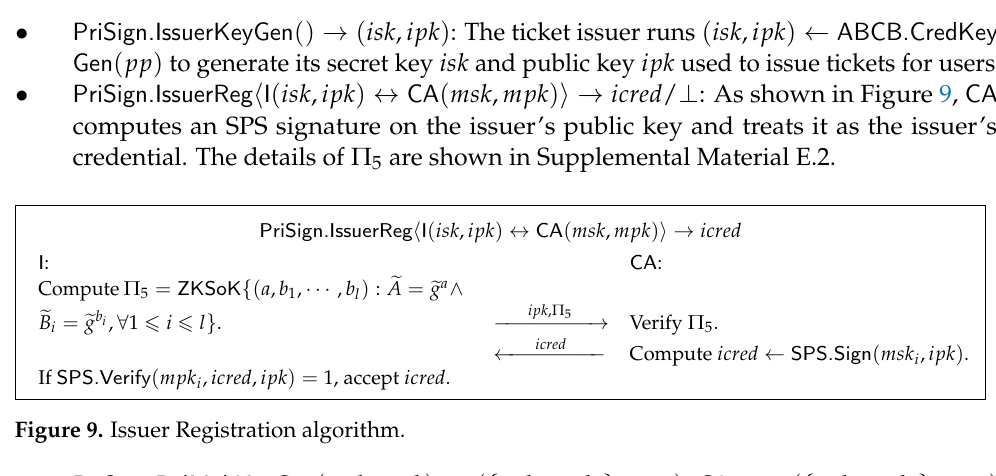
Figure 8. Setup algorithm.